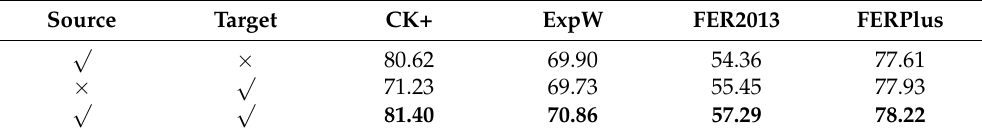
Table 2. Evaluation of the influences of anchor images on the AGA module. Source